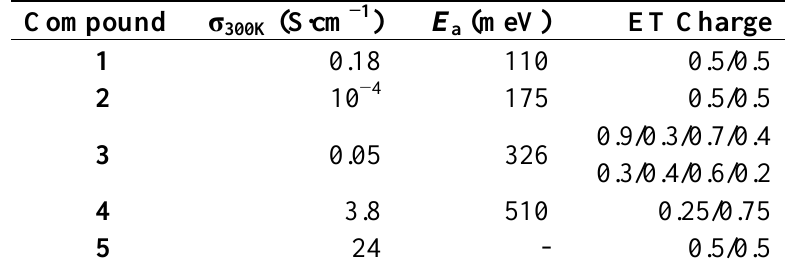
Table 11. Room temperature electrical conductivity values, activation energies and approximate charge distributions in compounds 1 – 5 .